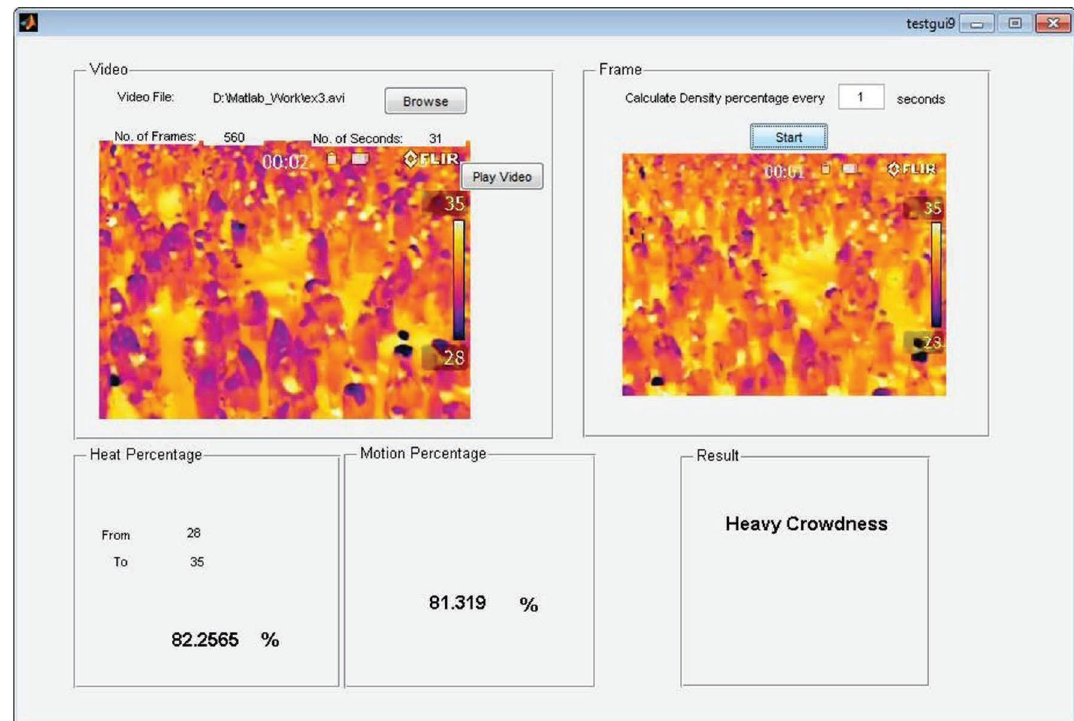
Figure 15: Sample result of real-time GUI for heavy crowd.